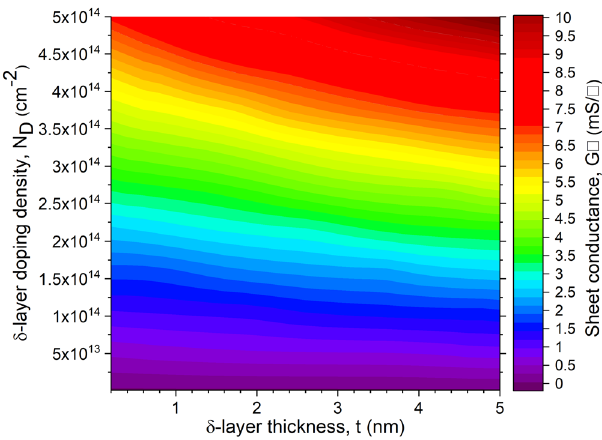
Fig. 6 Sheet electrical conductance for Si:P δ -layer systems. The sheet conductance, G □ , is shown as a function of δ -layer thickness, t , and donor doping density in the δ -layer, N D (for the linear impurity density α = 1). The signi fi cant deviation from the classical result, where the current, j , is proportional to the electron density, n , i.e., j ~ n (which would correspond to perfectly horizontal color bands) is due to the quantum-mechanical resistivity increase for sharper δ -pro fi